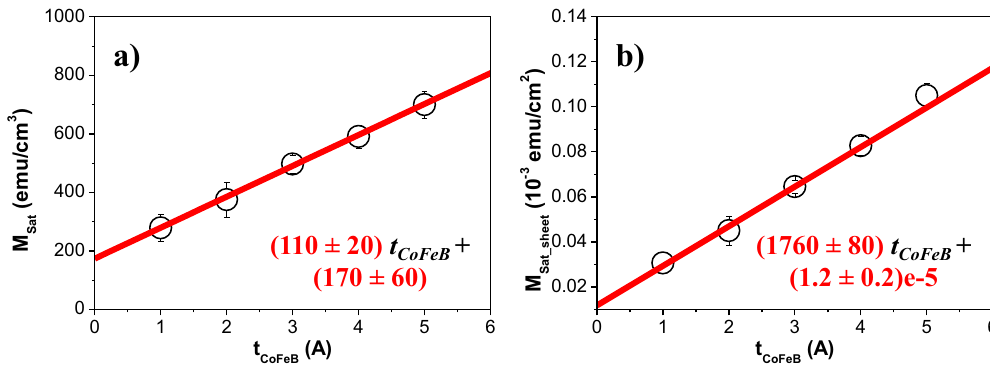
Figure 2. ( a ) Saturation magnetization, M Sat as a function of the CoFeB layer thickness ( t CoFeB ) . ( b ) M Sat_sheet as a function of the CoFeB layer thickness ( t CoFeB ) . The continuous red lines are linear